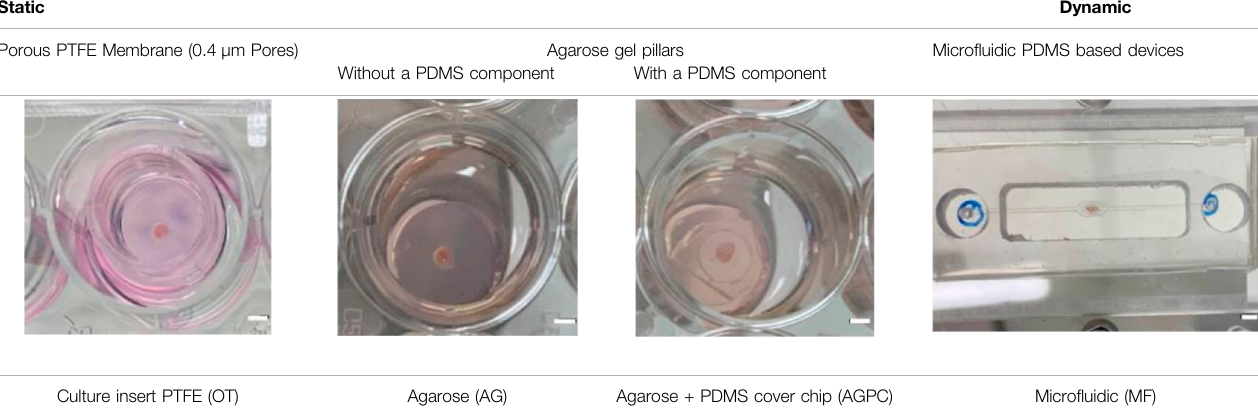
TABLE 1 | Summary of culture systems used in the